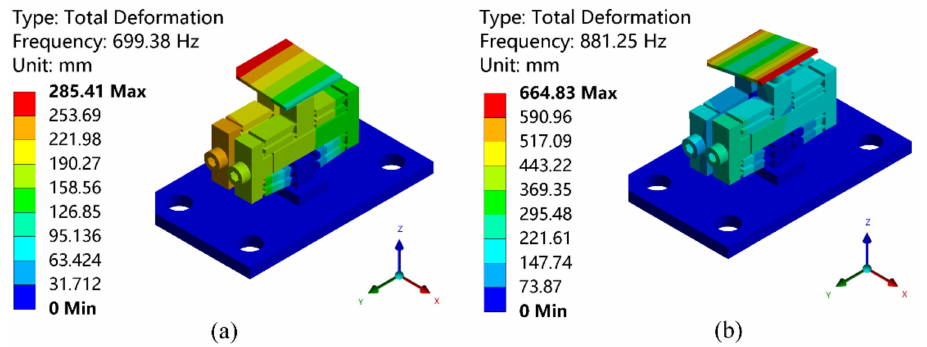
Figure 10. Natural frequency. ( a ) First natural frequency of 699.38 Hz; ( b ) Second natural frequency of 881.25